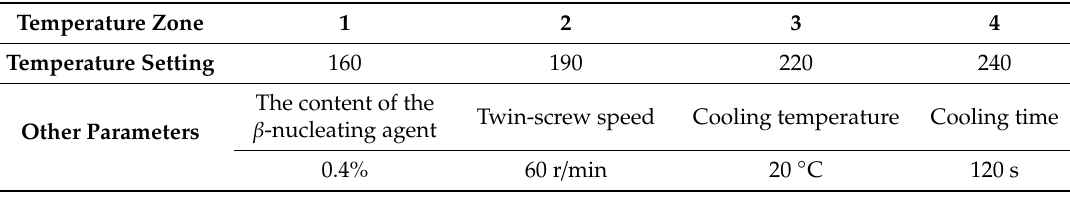
Table 1. Process parameters of β -nucleated